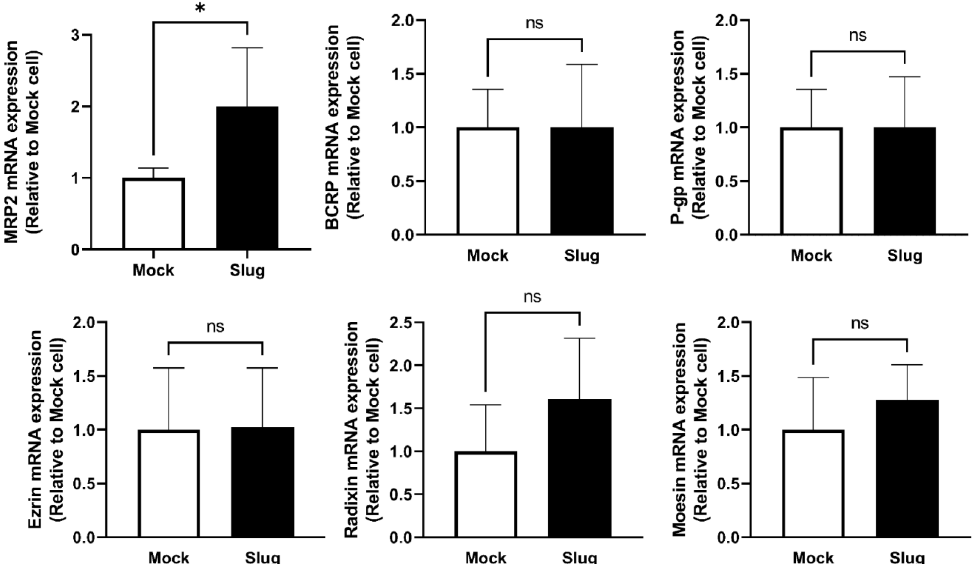
Figure 2. mRNA expression levels of multidrug resistance protein 2 (MRP2), breast cancer resistance protein (BCRP), P-glycoprotein (P-gp), ezrin (Ezr), radixin (Rdx), and moesin (Msn) in Slug-transfected HCC827 cells and Mock-transfected cells. mRNA expression of MRP2 significantly increased after transfection with Slug plasmid (n = 4, ns: not significant, * p < 0.05). qRT-PCR data represented the mean ± SD.